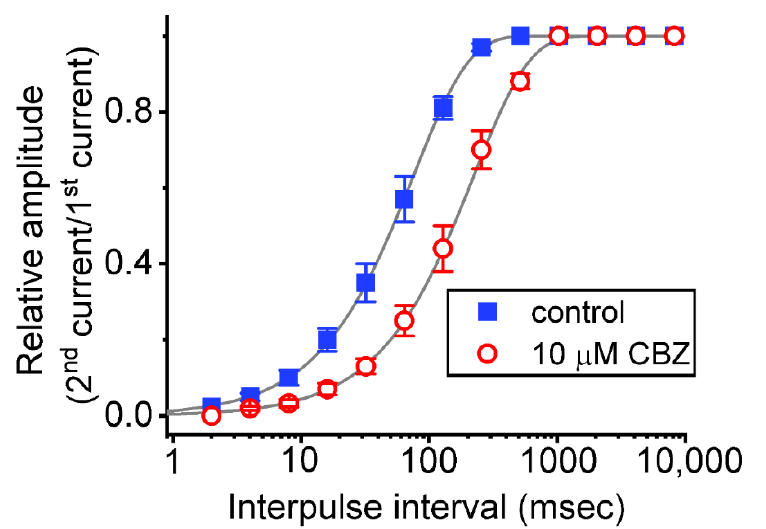
Figure 5. Modification by CBZ on the recovery of I Na(T) inactivation evoked by varying interpulse intervals with a geometrics-based progression. In these measurements, we put cells bathed in Ca 2+ - free Tyrode’s solution, while we filled up the recording pipette with Cs + -enriched solution. Each tested cell was depolarized from − 80 to − 10 mV for a duration of 30 ms, and subsequently different interpulse durations with a geometrics-based progression (common ratio = 2) were applied to it. The relative amplitude of peak I Na was measured as a ratio of the second peak amplitude divided by the first peak amplitude. The recovery time course (indicated by the smooth gray line) in the presence and presence of 10 μ M CBZ was noticed to display an exponential increase as a function of the interpulse interval, with a time constant of 75.3 and 223 ms, respectively. Notably, the horizontal axis is illustrated with a logarithmic scale. Each point represents the mean ± SEM (n = 8). The analysis was made by one way ANOVA (F value = 5.3, p < 0.05). 2.6. CBZ-Induced Increase in Cumulative Inhibition of I Na(T) Inactivation in Neuro-2a Cells The I Na(T) inactivation could be accumulated during repetitive short pulses [48,56–58]. Thus, additional measurements were taken to see whether CBZ could modify the inacti- vation process of I Na(T) evoked in a train of depolarizing stimuli. The tested cell was held at − 80 mV, and the stimulus protocol, i.e., repetitive depolarization to − 10 mV (20 ms in each pulse with a rate of 40 Hz for 1 s), was applied to it. The I Na(T) inactivation seen in Neuro-2a cells was evoked by a 1 s repetitive depolarization from − 80 to − 10 mV with a decaying time constant of 58.4 ± 3.8 ms (n = 7) in the control period (i.e., CBZ was not present) (Figure 6). That is, there is a rapid current decay in a single-exponential fashion. Of additional note, during exposure to 30 μ M CBZ, the exponential time course of I Na(T) evoked by the same train of depolarizing pulses was conceivably reduced to 21.1 ± 3.2 ms (n = 7; t value = 3.1; p < 0.05), in addition to a decrease in I Na(T) amplitude. Under this sce- nario, the experimental observations indicate that, apart from its reduction in current magnitude, under cell exposure to CBZ, the decaying time course of I Na(T) elicited by a 1 s train of a depolarizing pulse (i.e., accumulative inactivation of the current) can be overly enhanced in these cells.